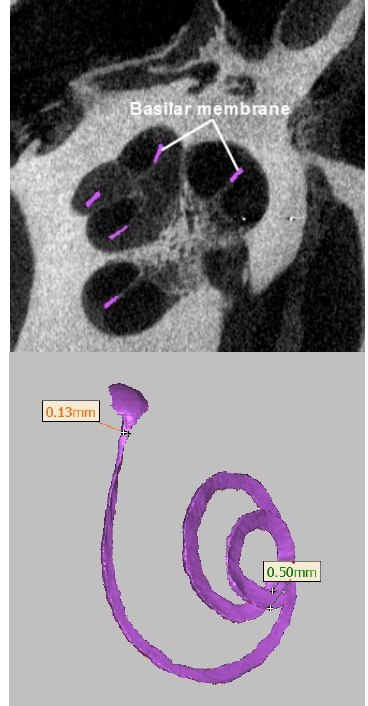
Fig. 4. Tympanic membrane ( TM).